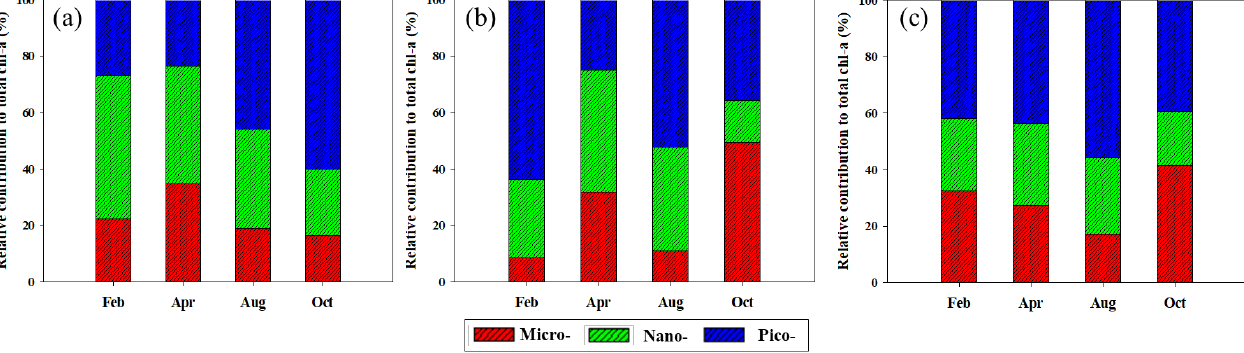
Figure 5. Seasonal variations in different size compositions of chl- a in the YS ( a ), the SS ( b ), and the EJS ( c ), 2018.